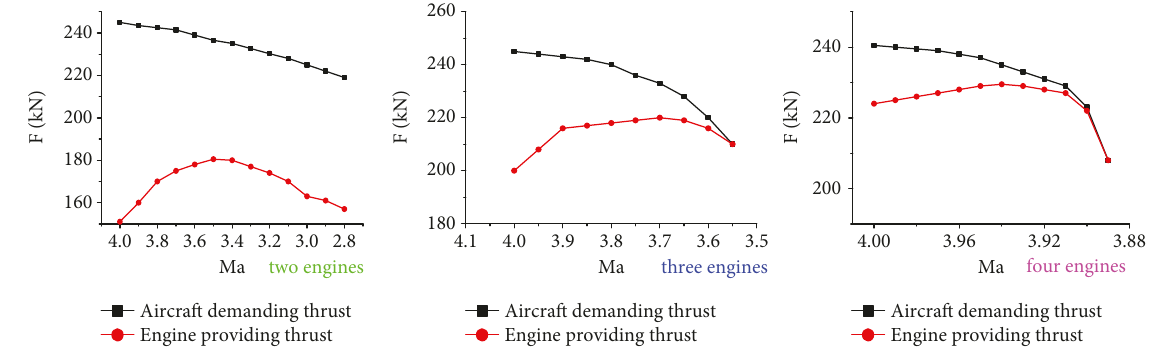
Figure 12: Curve of Ma - F (double, three, and four engines). Table 3: Thrust requirements of the TBCC engine at main operation